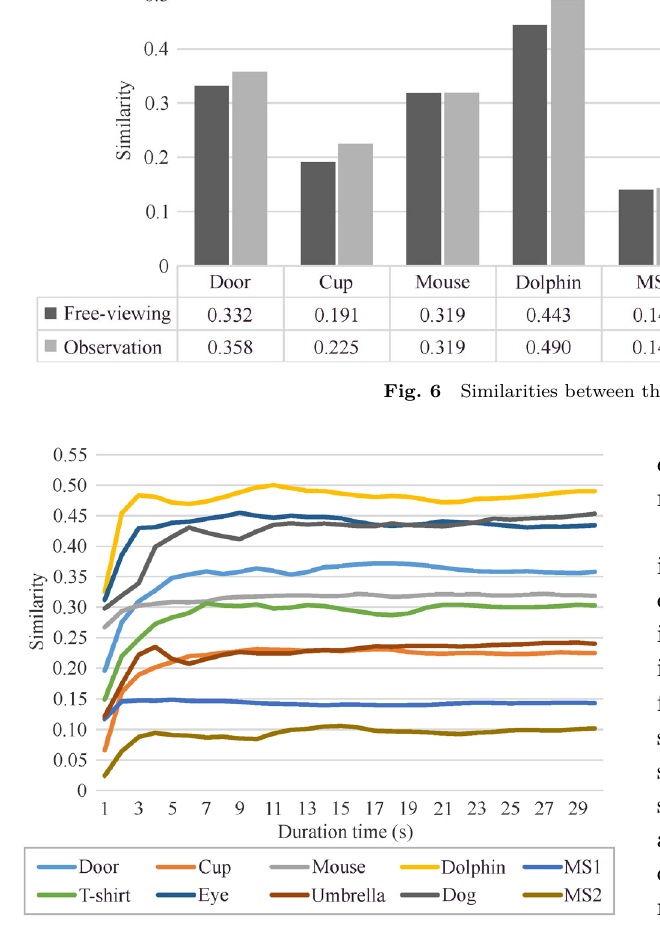
Fig. 7 Similarity values for the observation task for each duration time. The similarity values at 30 s correspond to the data in Fig.